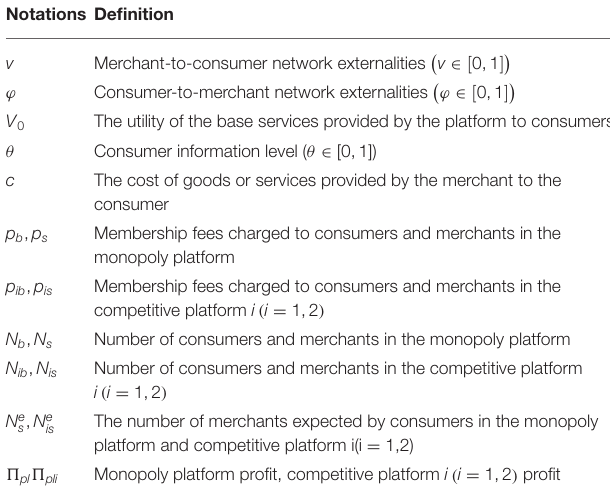
TABLE 1 | Definition of notations. Notations